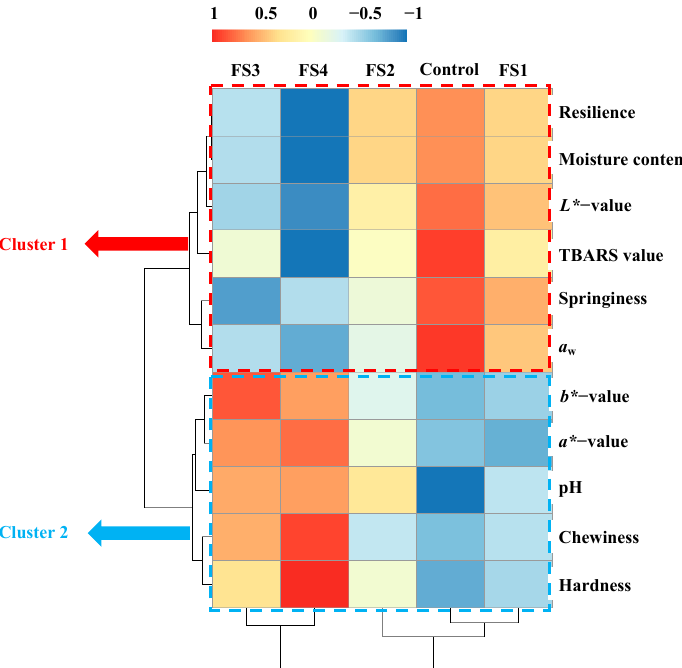
Figure 6. Hierarchical cluster analysis (HCA) of Harbin dry sausages with different replacement levels of CFS after fermentation. Control: 100% backfat; FS1: 80% backfat and 20% CFS; FS2: 60% backfat and 40% CFS; FS3: 40% backfat and 60% CFS; FS4: 20% backfat and 80% CFS.